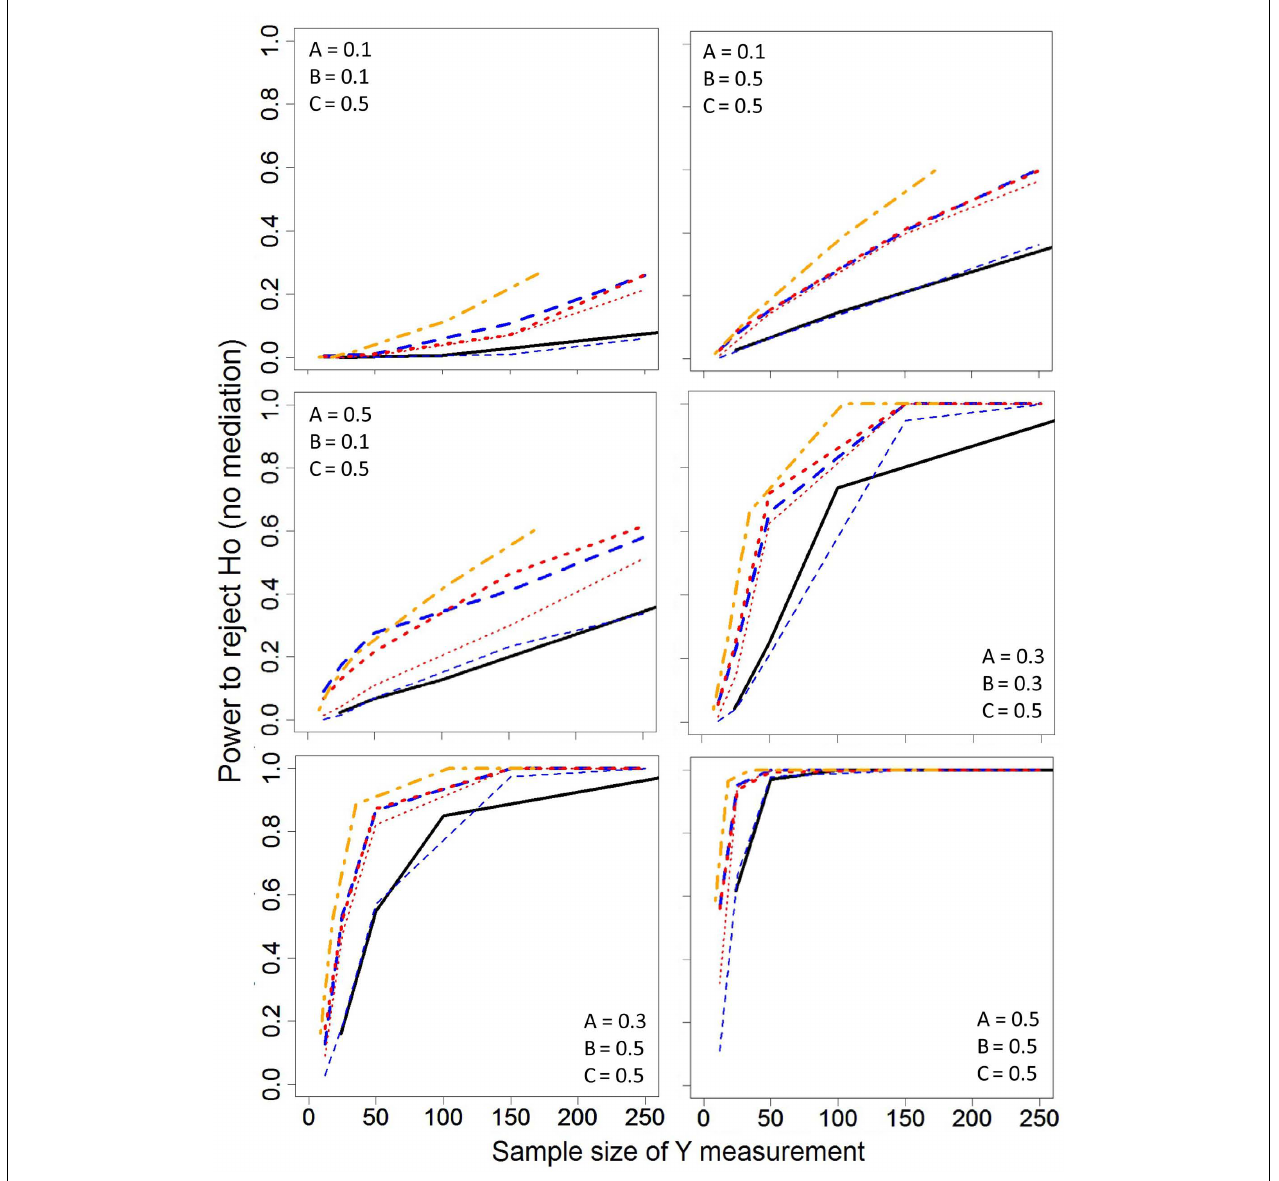
FIGURE 3 | Statistical power estimates for the various sampling strategies across different correlation structures. Line specifications are the same as in Figure 2